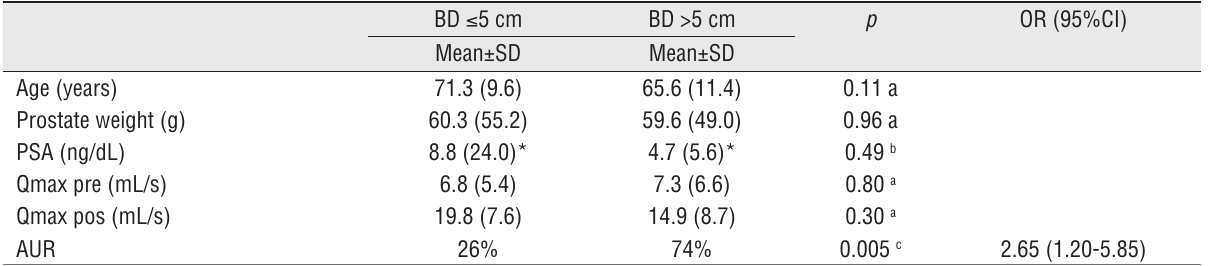
Table 2 - Bladder diverticula ≤ 5 cm and >5